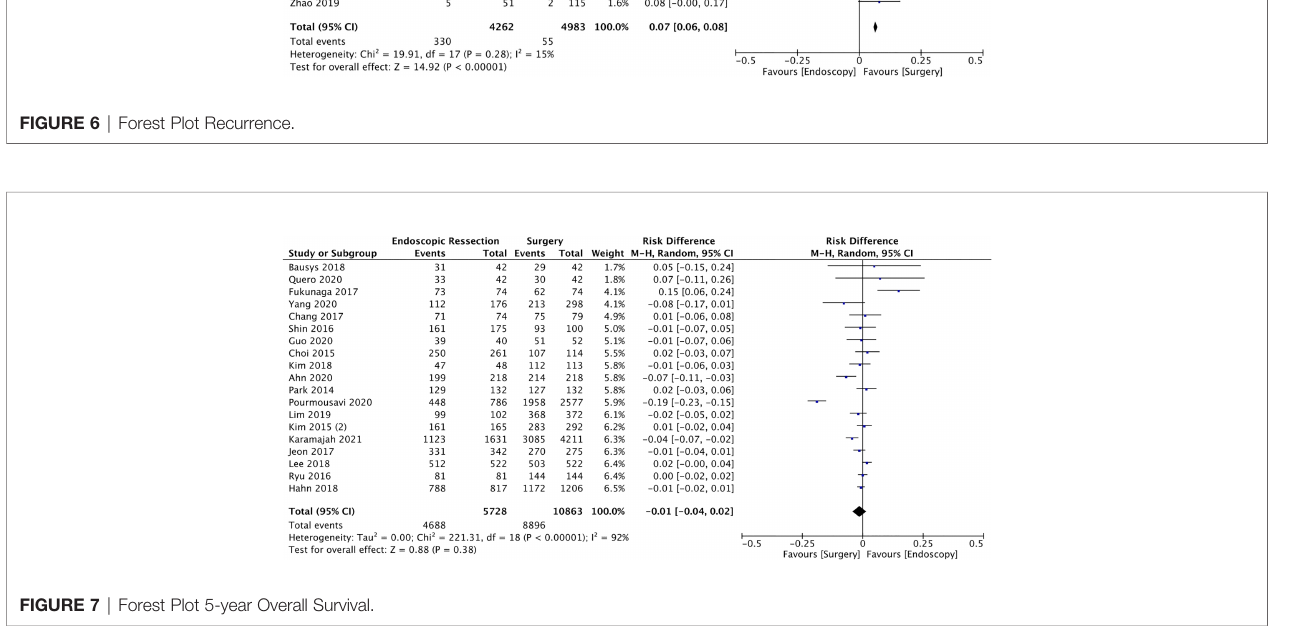
FIGURE 7 | Forest Plot 5-year Overall Survival.